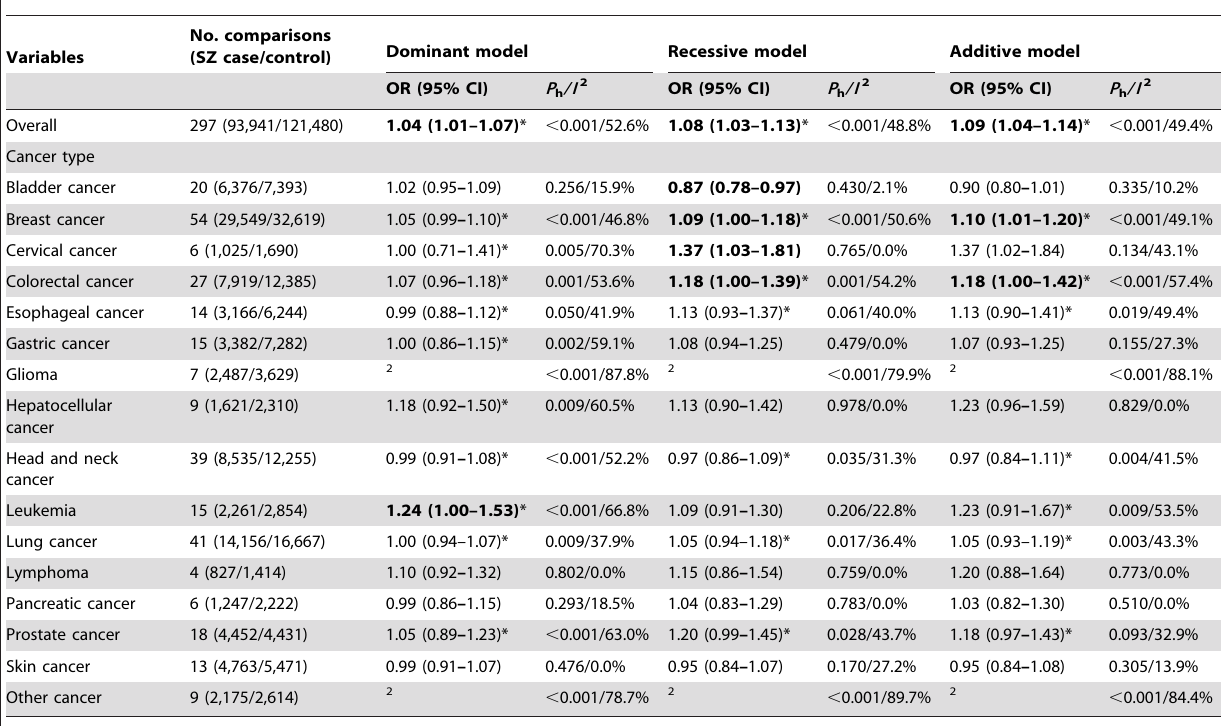
Table 1. Stratified analysis of XRCC1 Arg399Gln polymorphism on cancer risk 1 .